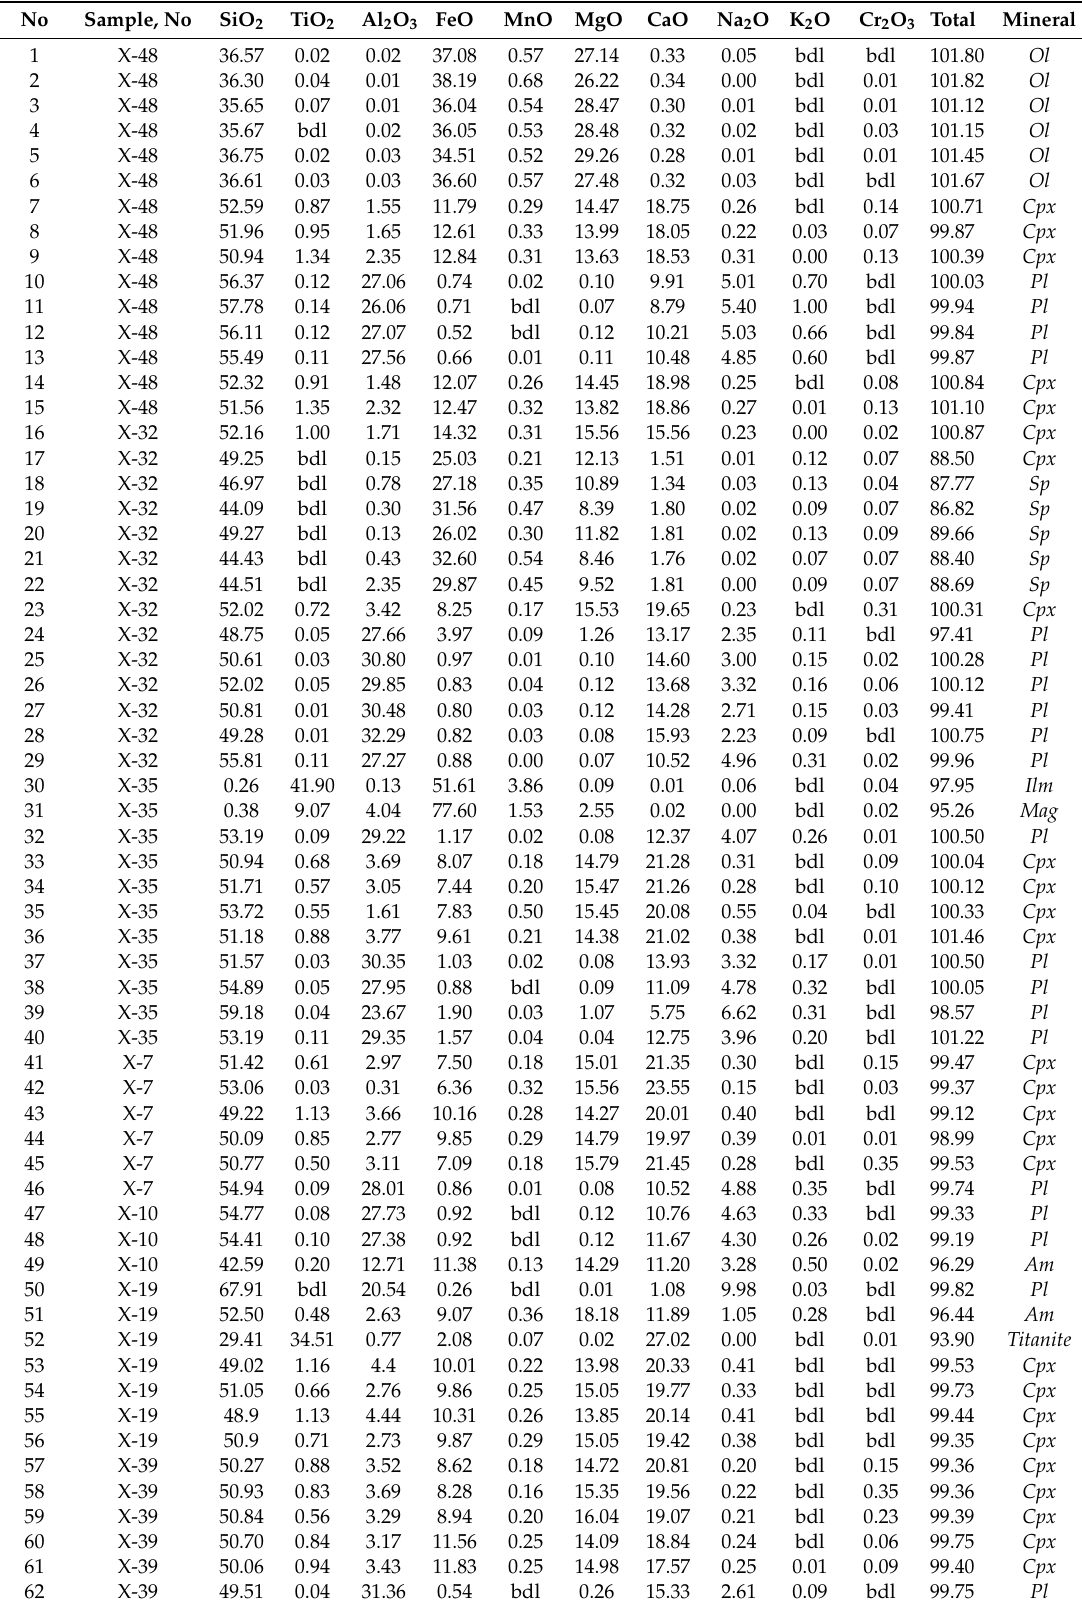
Table 4. Composition of rock-forming minerals from intrusive rocks of the Khalil site,